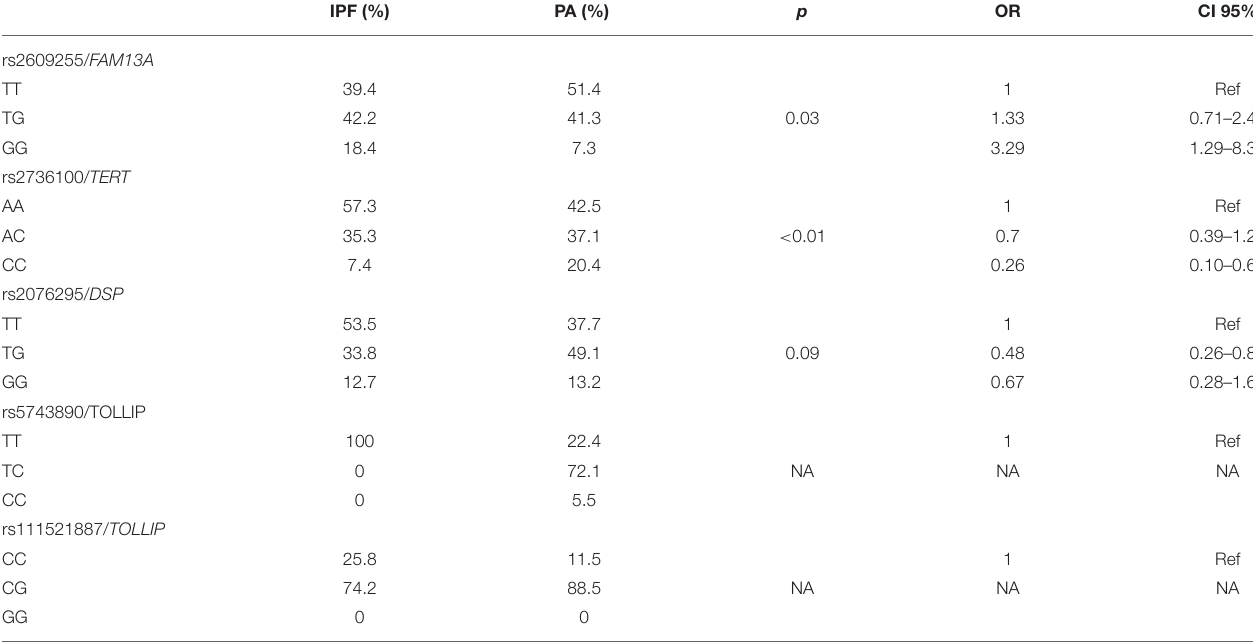
TABLE 5 | Codominant model of IPF vs. PAC